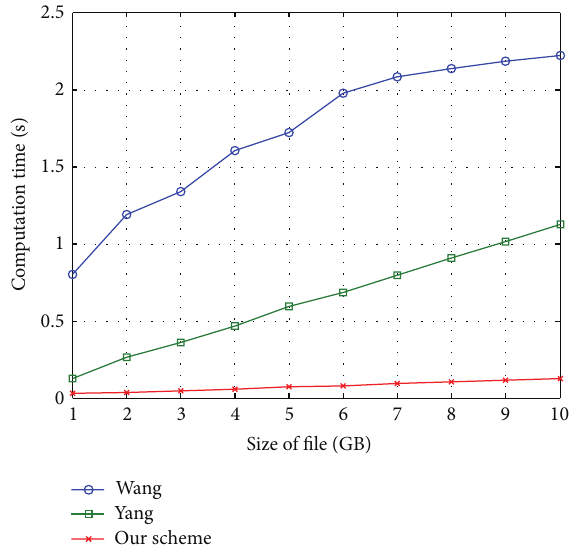
Figure 9: Comparison of computation cost under different file size from 1GB to 10GB when the number of update requests is